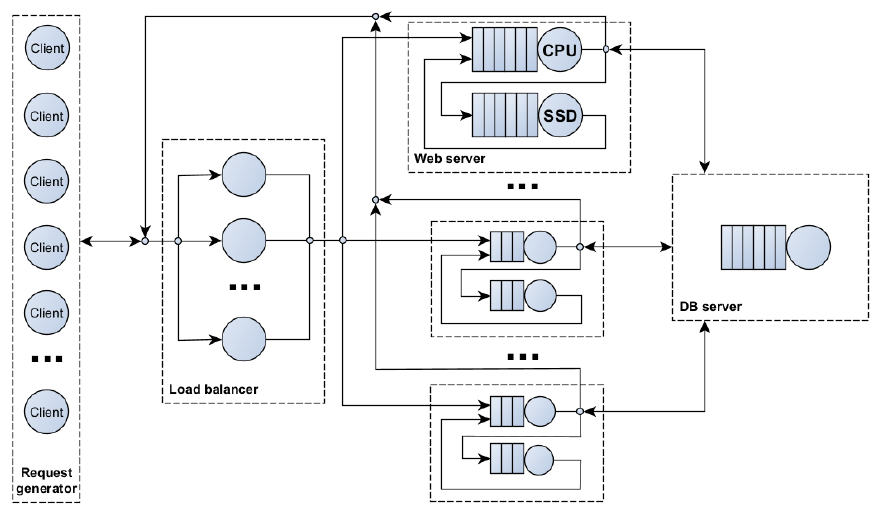
Figure 3. The simulator